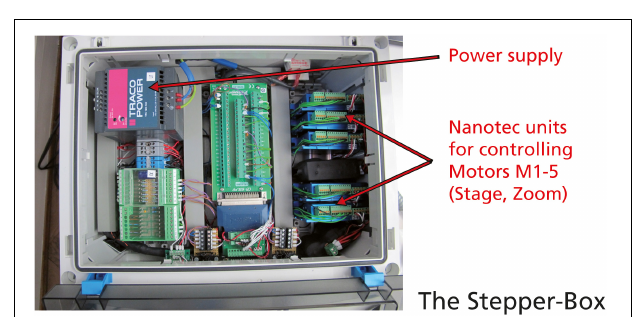
FIGURE 5 | The new stepping box for System AMOR 2. Power supply, and five C5 motor controllers from